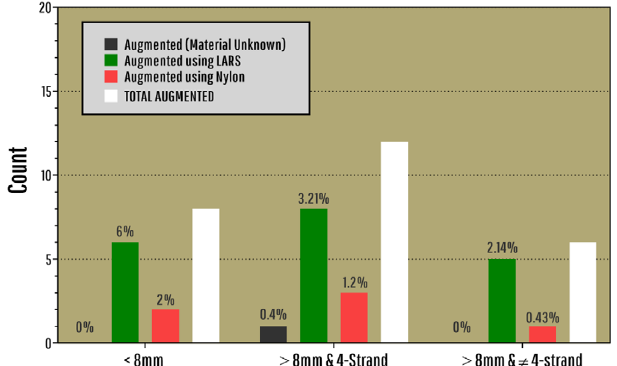
Figure 2. Bar Plot illustrating the number of augmentations and the materials used. In addition, the percentage of each augmentation is written on top of the bars.